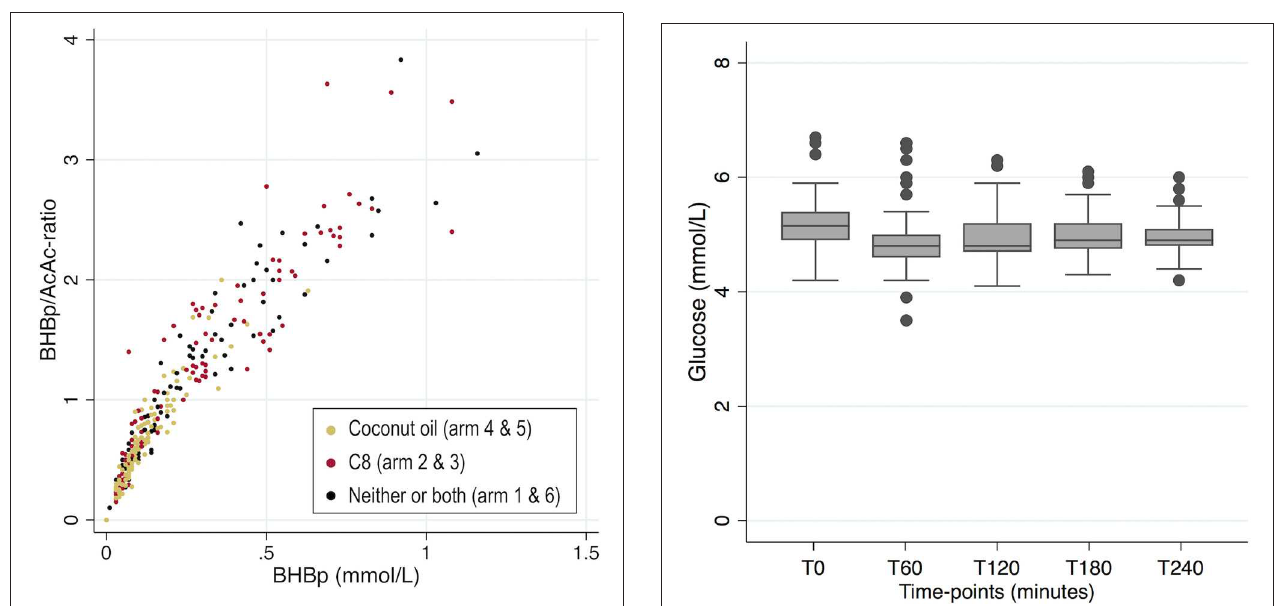
The very similar BHBv paths of C8 + Coc and C8 ( Figure 2 ) suggest that the metabolization of C8 does not slow down by increased competition from 30 vs. 10 g of other fatty